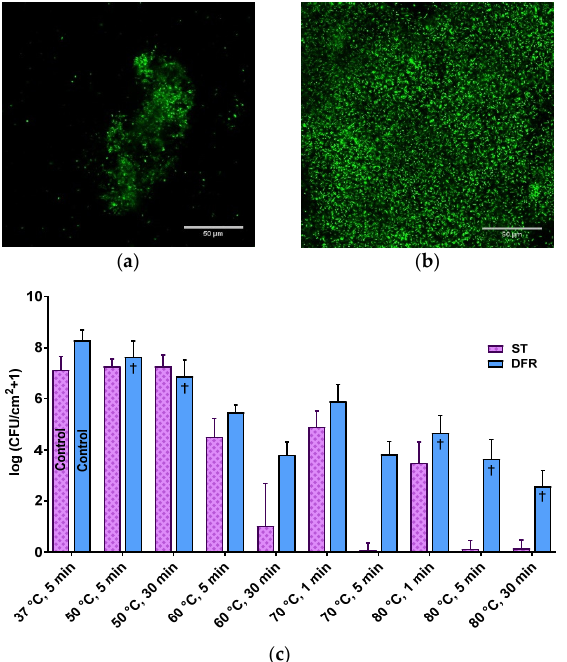
Figure 1. Culture protocols produce biofilm with starkly different population density, architecture, and thermal susceptibility. ( a , b ) are overhead views of confocal fluorescent images of shaker table ( a ) and drip flow reactor ( b ) biofilms. ( c ) Effect of thermal shock on population density of P. aeruginosa ST and DFR biofilms. † from [35].